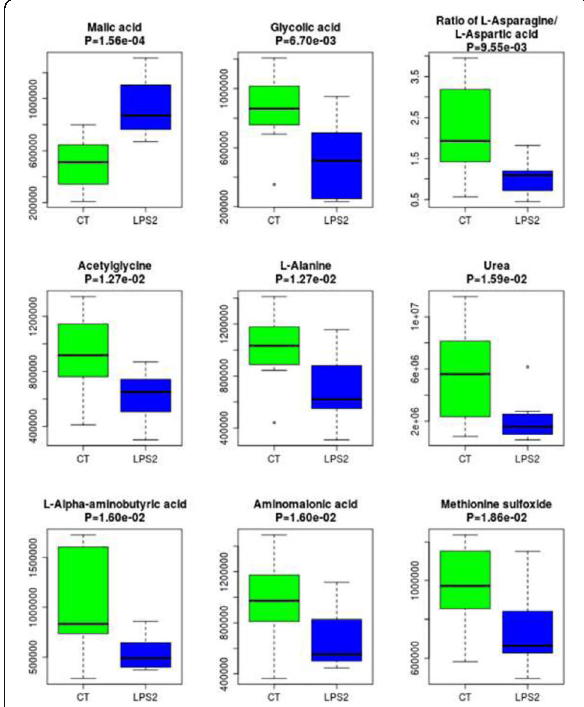
Fig. 3 (abstract 0162). Top ranked differential metabolites between control (CT) group and LPS-2hour (LPS2)